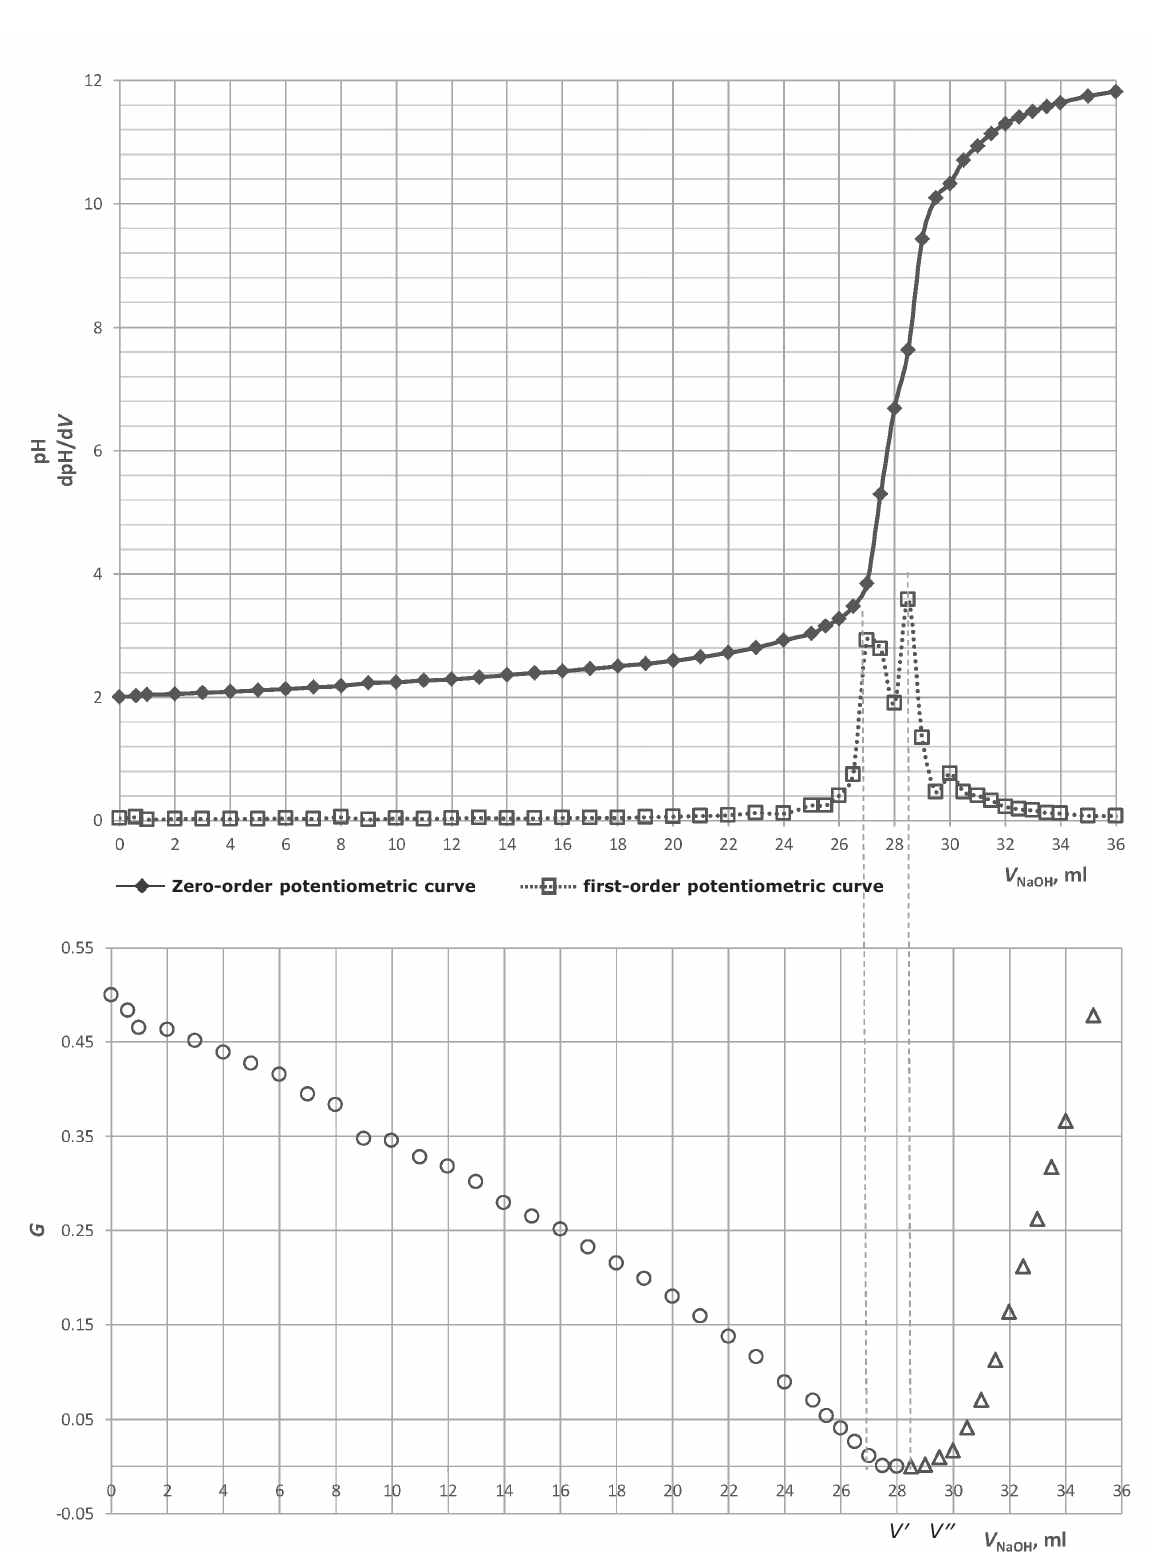
Fig. 3 – Zero-order, first-order potentiometric curves and Grans plot of